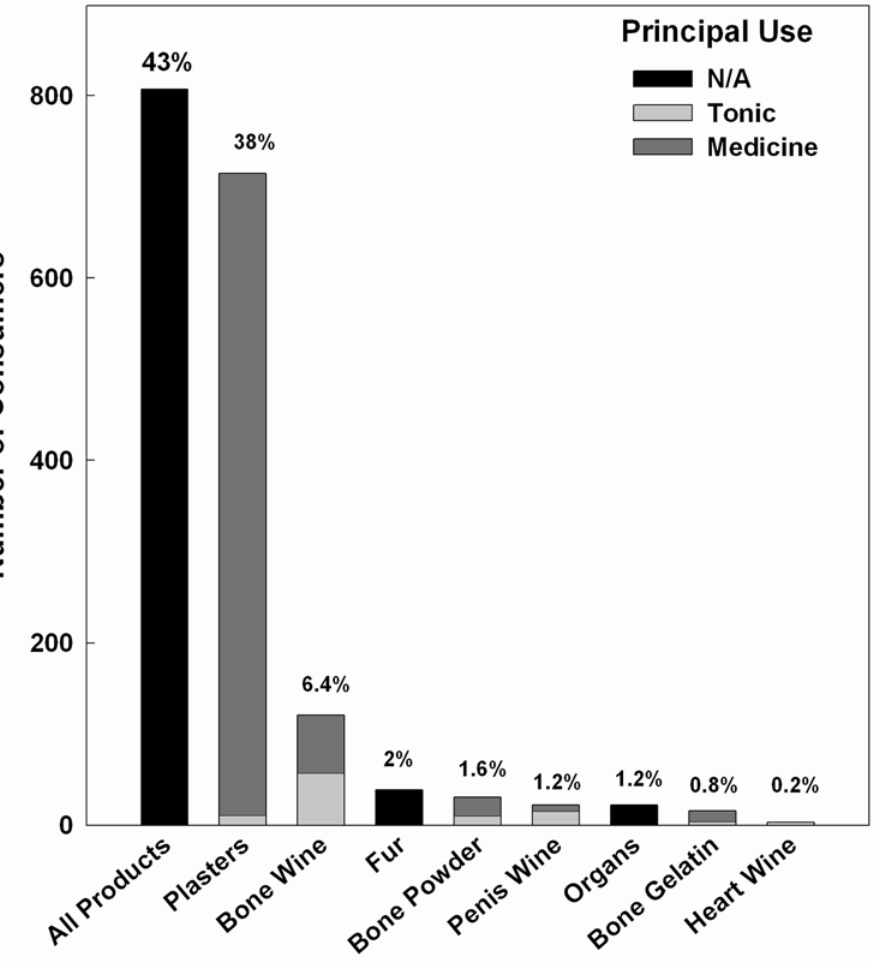
Figure 1. Survey of tiger product consumption in Chinese urban areas. Where applicable, respondents were asked to specify if the product was primarily used as a medicine, or as a health tonic. In this study we define medicine as a substance used to cure an illness, while a tonic is a substance used to primarily to promote general health and well being.